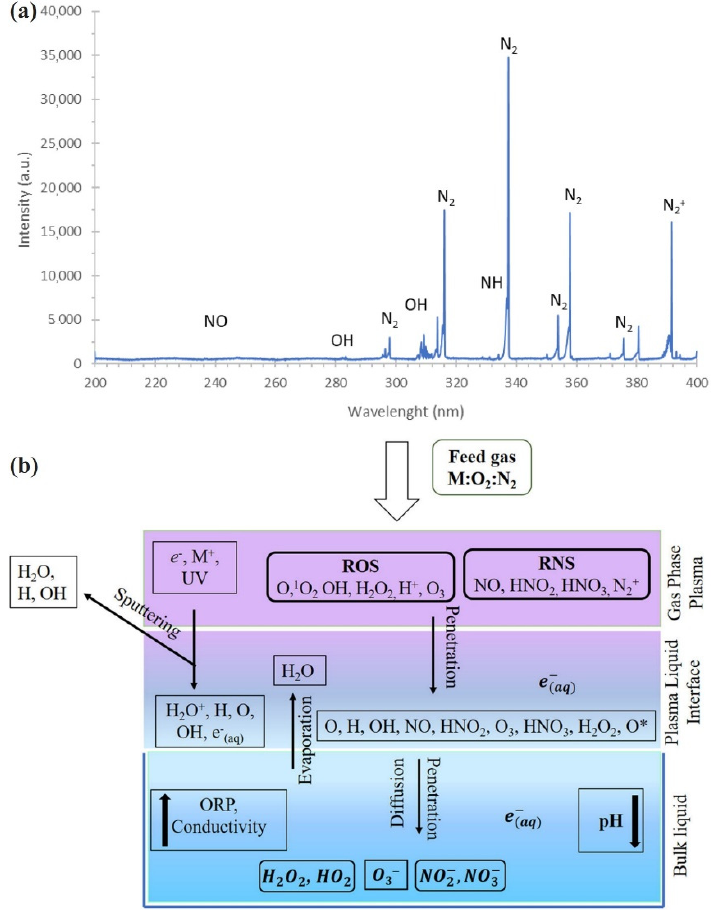
Figure 2. Reactive species in gas phase and liquid phase. ( a ) An emission spectrum of plasma in the gas phase of DBD in the range from 200–400 nm [17]. ( b ) General picture of CAP-aqueous solution interactions. Reprinted with permission from Ref. [20]. Copyright 2019 John Wiley and